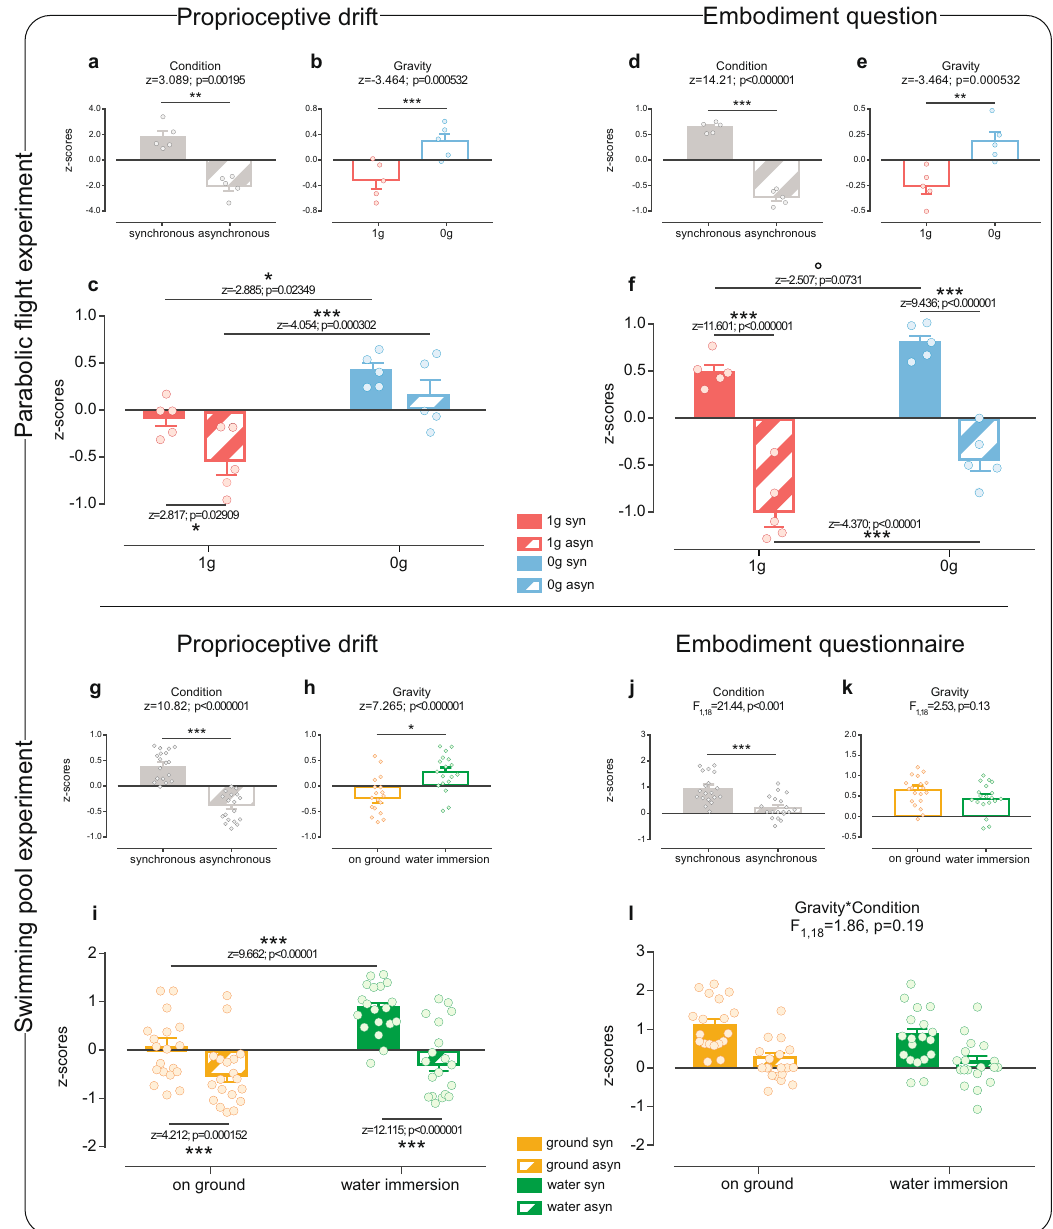
Fig. 2 Results. Upper panel ( a – f ): Parabolic fl ight experiment. Lower panel ( g – l ): Swimming pool experiment. Error bars represent standard errors of the means. Dots represent single-subject values, i.e., the mean of each participant ’ s judgment in each condition. °tendency toward statistical signi fi cance; * p < 0.05; *** p < 0.001. Values are normalized in z